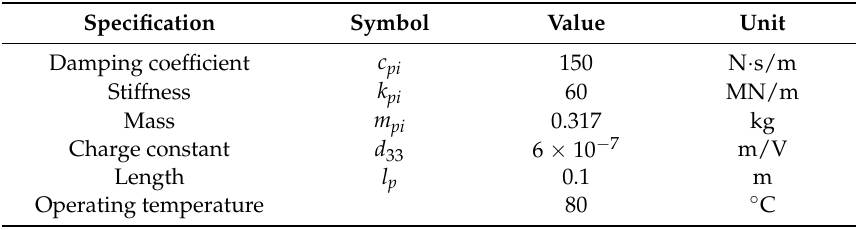
Figure 4. Frequency response of the return spring with different stiffnesses: ( a ) Magnitude, ( b ) Phase delay. Table 1. Mechanical properties of the piezostack